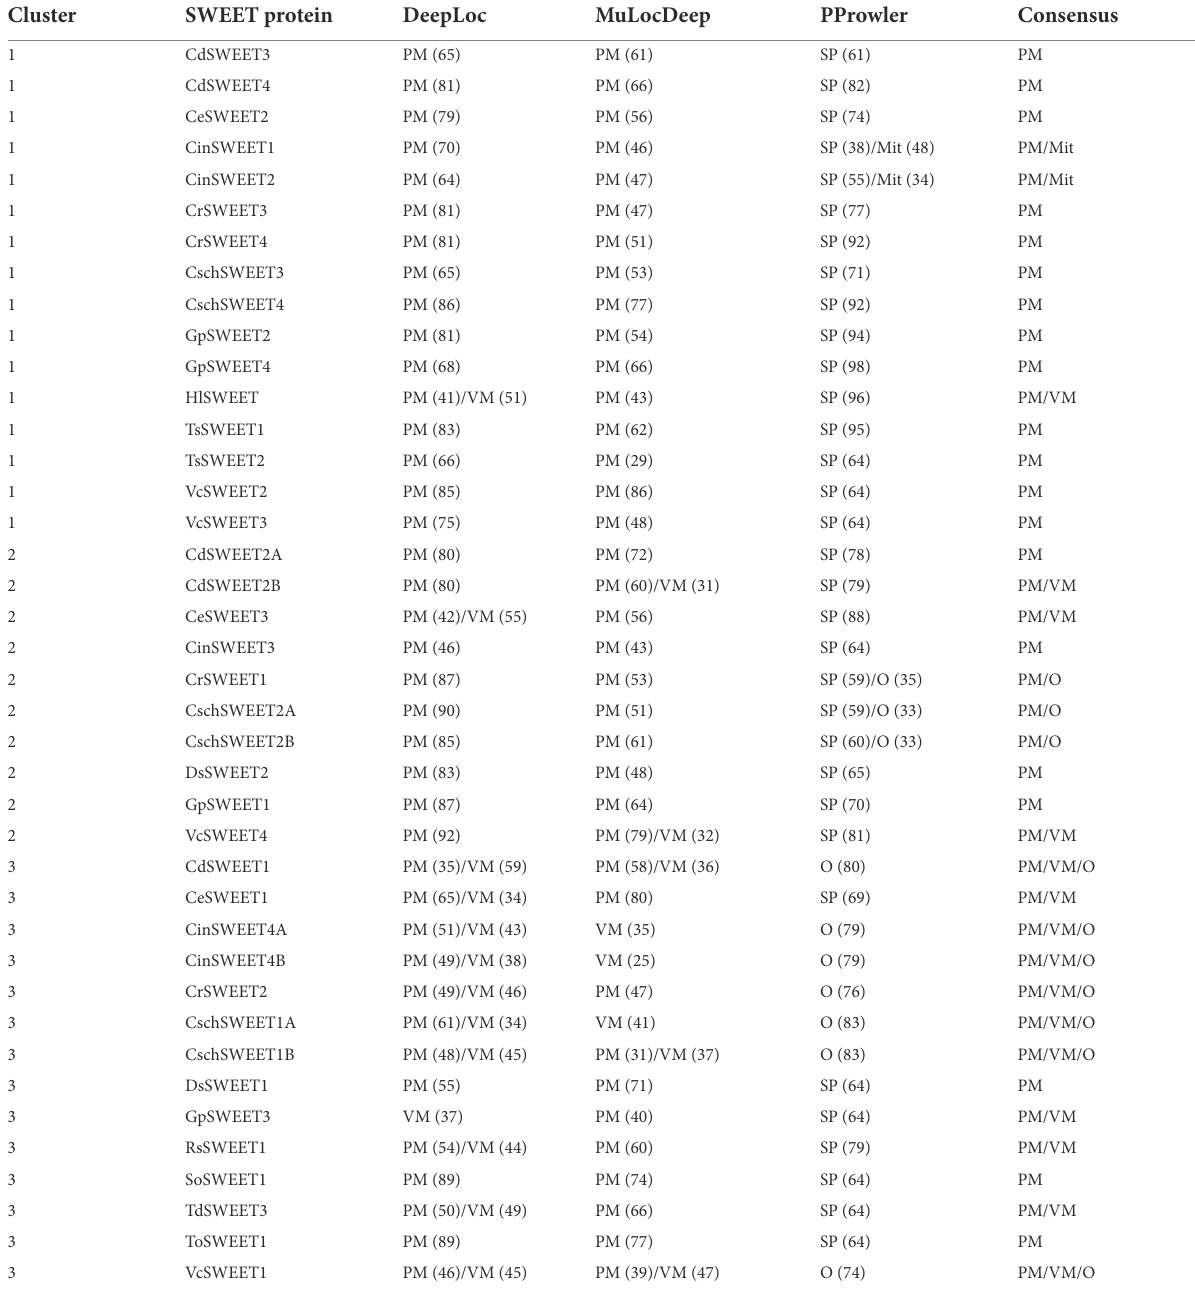
TABLE 2 Subcellular localisation predictions of Cluster 1 to 3 Chlorophyta